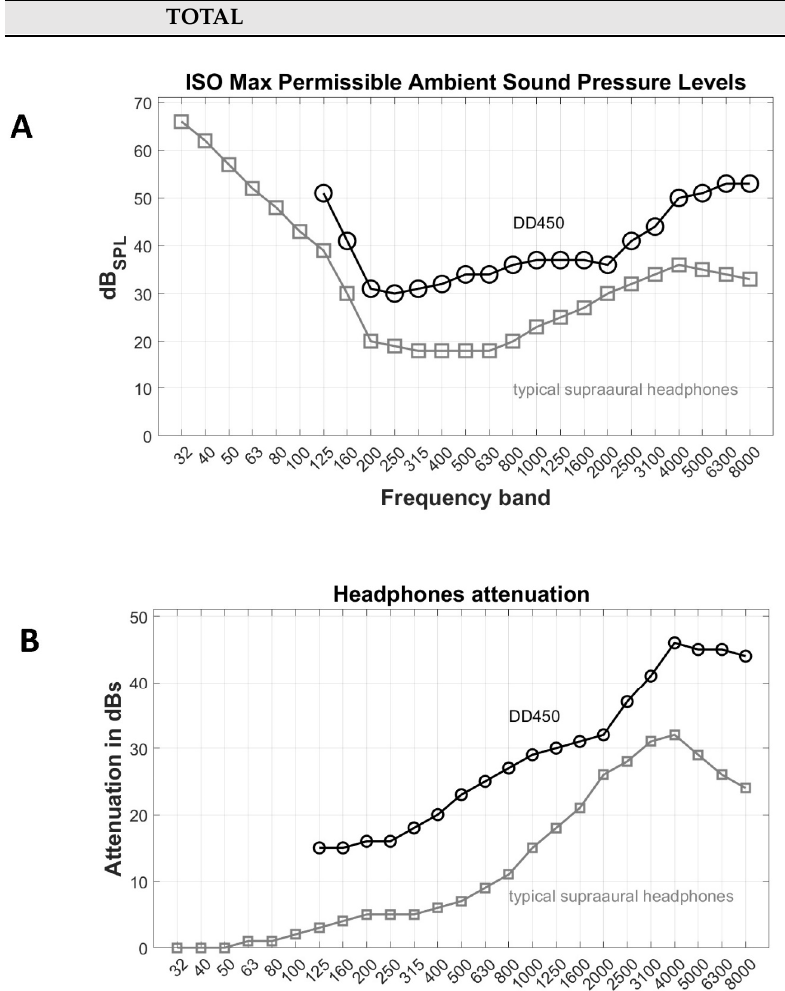
Figure 1. ( A ) Max Permissible Ambient Sound Pressure Level according to ISO 8253-1 [13] when DD450 or typical supra-aural headphones are used. ( B ) DD450 and typical supra-aural headphones’ a tt enuation.